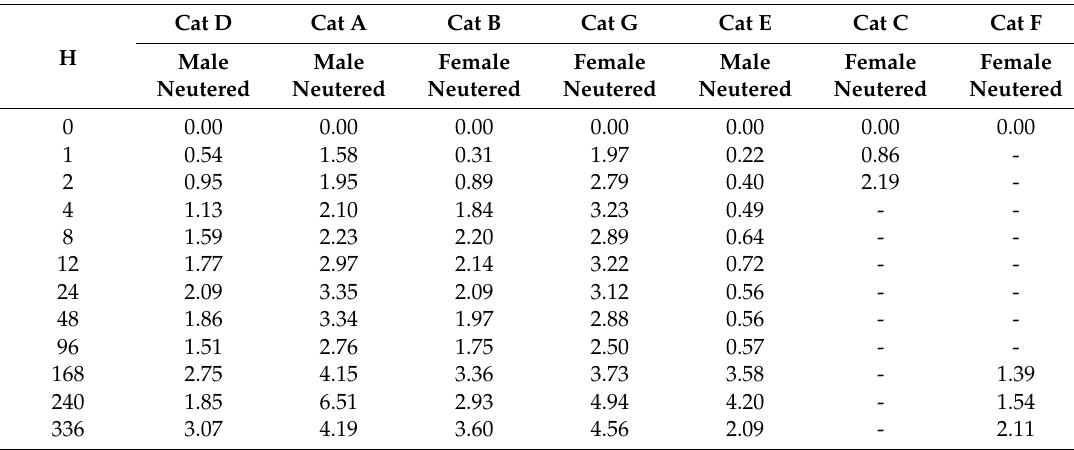
Figure 2. Mefloquine plasma concentrations (ug/mL) over the first 24 h after cats were administered 62.5 mg (10–12 mg/kg) mefloquine at t = 0.